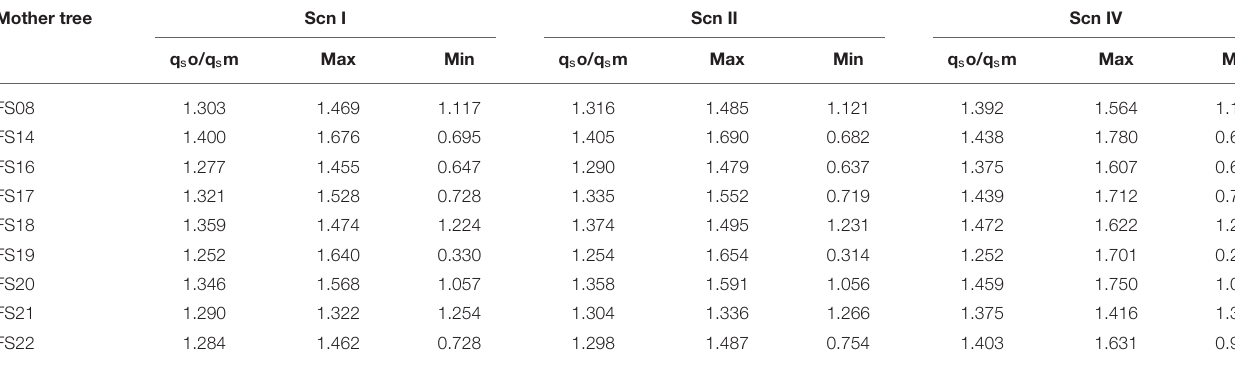
Mean, standard deviation (in brackets), maximum and minimum values per family are provided.